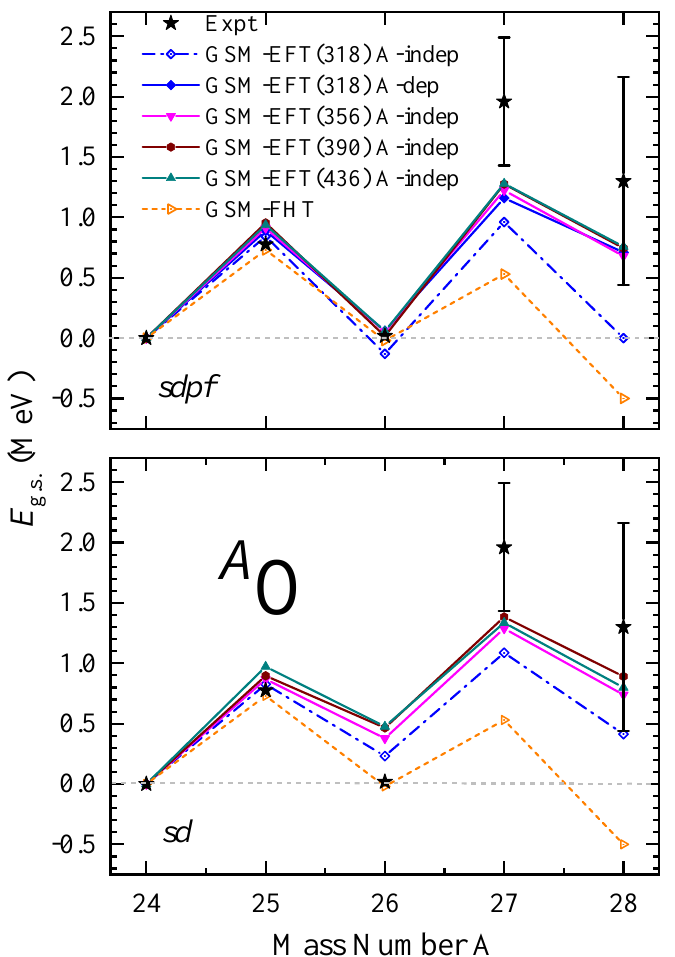
Figure 5. Energies of ground states in 24 − 28 O, calculated by GSM within the sdpf ( s 1/2 , p 1/2,3/2 , d 3/2,5/2 , f 5/2,7/2 partial waves) ( upper ) and sd ( s 1/2 , d 3/2,5/2 partial waves) ( lower ) model spaces, using the effective field theory (EFT) EFT(318)(the value within braket stands momentum cut- offs), EFT(356), EFT(390), EFT(436), and Furutani–Horiuchi–Tamagaki (FHT) interactions, with A-independence ( A -indep) or A-dependence ( A -dep) (see details in Ref. [42]). Results are compared with the experimental data available, represented by a star. The data for 25,26 O and 27,28 O are taken from experiment (see Refs. [8,74]) and evaluations given in AME2016 [78] (with permissions from Ref.